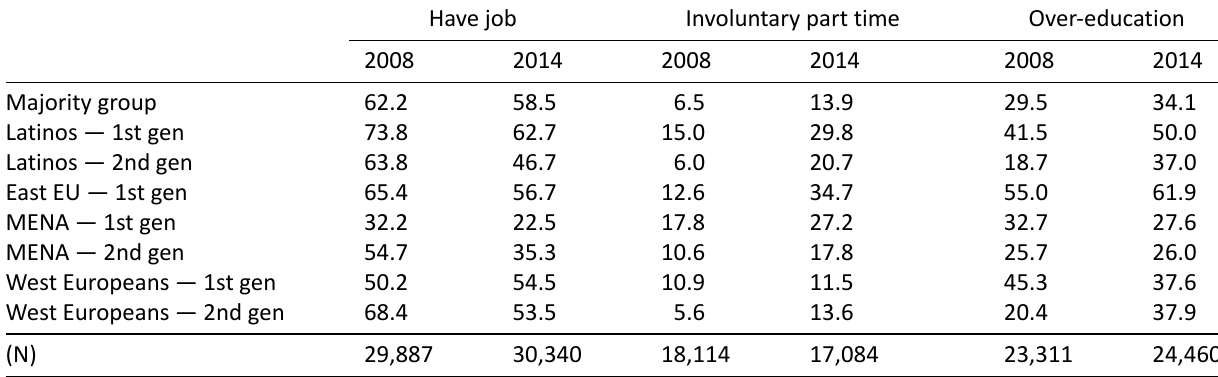
Table 4. Labour market outcomes by ethnicity and generation in 2008 and 2014 (females). Have